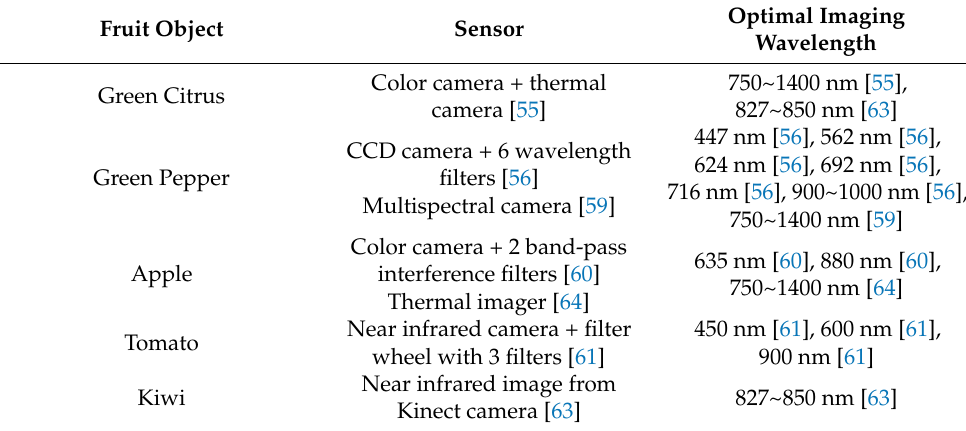
Table 2. Visual unit for fruits in the similar-colored